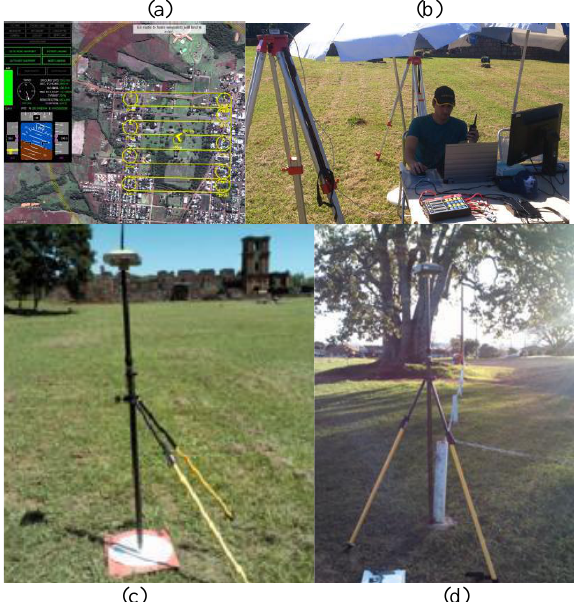
Figure 10. (a) Flight plan and control software; (b) Flight control station; (c) Control points measurement; (d) Check points measurement.